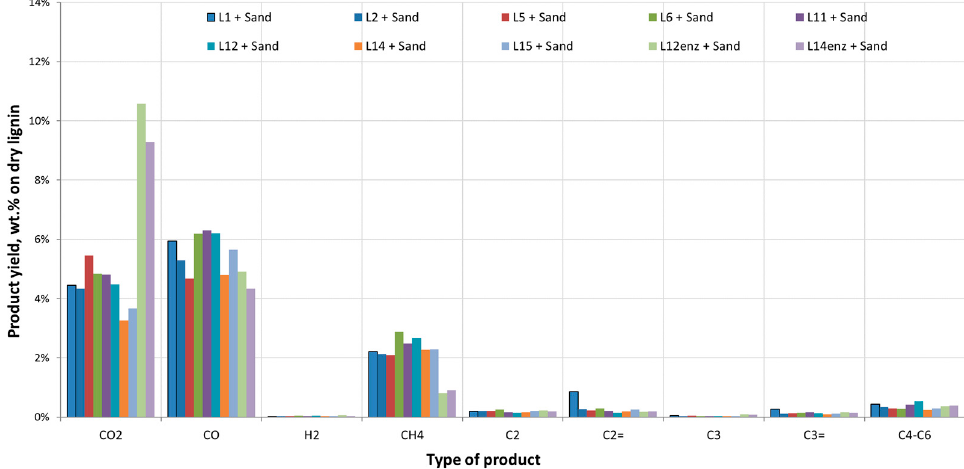
Figure 3. Individual gas yields (dry basis) from thermal pyrolysis of organosolv-derived beechwood lignins.